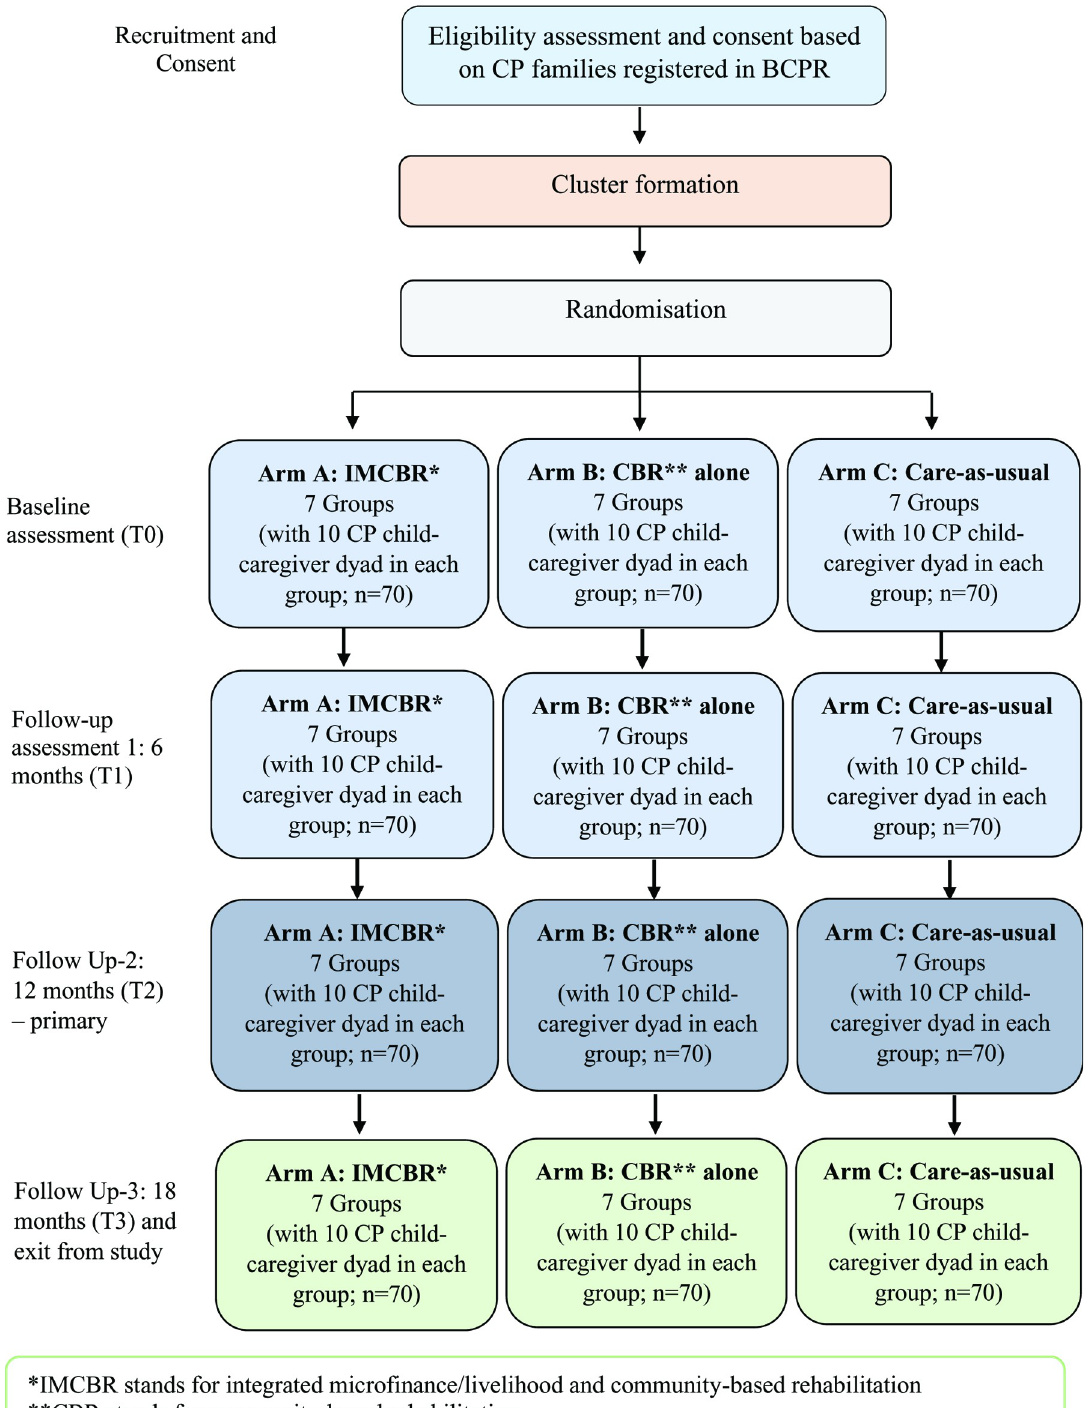
Fig 1. Study design (consolidated standards of reporting trials